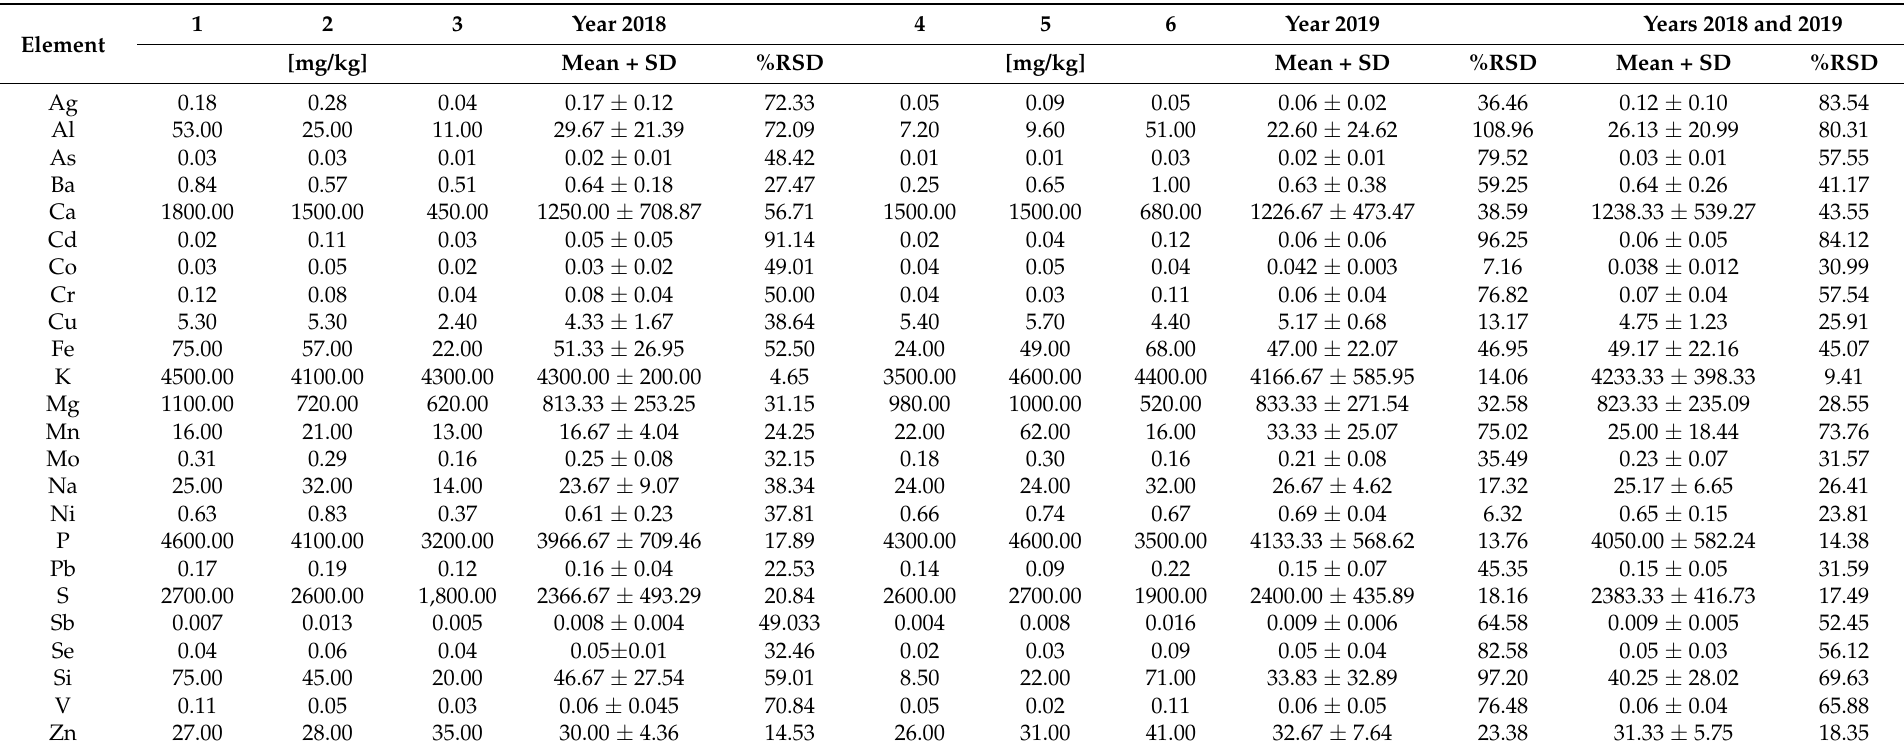
Table 1. Levels of 24 selected elements measured in bee pollen along with mean, standard deviations (SD), and relative standard deviation (%RSD) values, calculated for each year separately and all samples in total; 1, 2, 3—samples collected in 6 May, 23 June and 8 July 2018, respectively; 4, 5, 6—samples collected in 16 May, 2 June and 20 July 2019, respectively. Values of mean and SD are expressed in